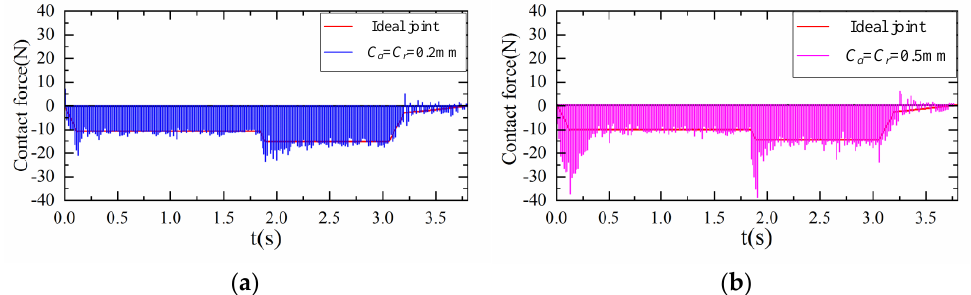
Figure 13. Contact force of joint B in the X direction. ( a ) The contact force in the X direction when both clearances are 0.2 mm and ( b ) the contact force in the X direction when both clearances are 0.5 mm.